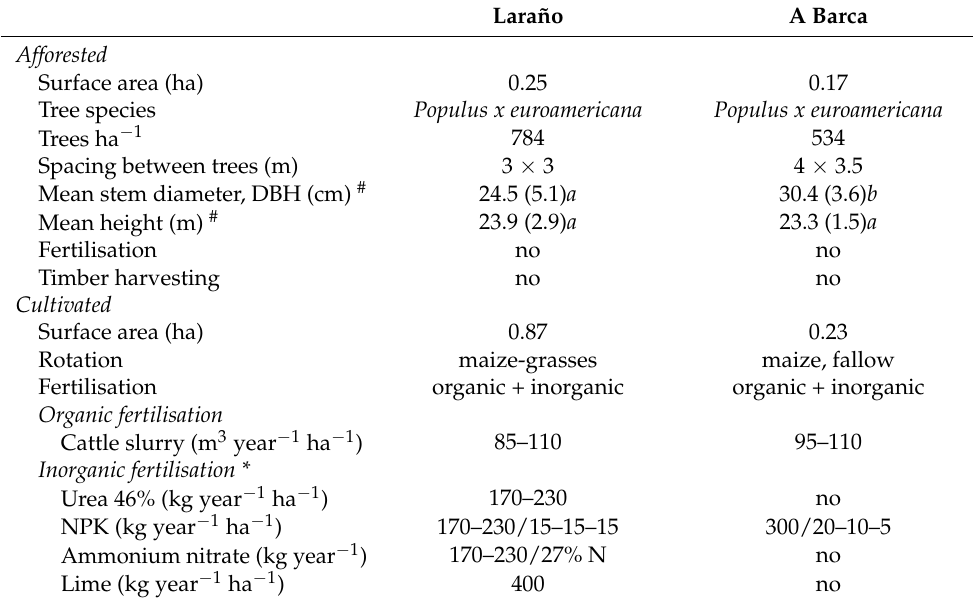
Table 1. Data on the type of management and characteristics of the vegetation in the study plots. Different letters indicate significantly different mean values between sites ( p < 0.01). Values are means and standard deviation (in brackets).